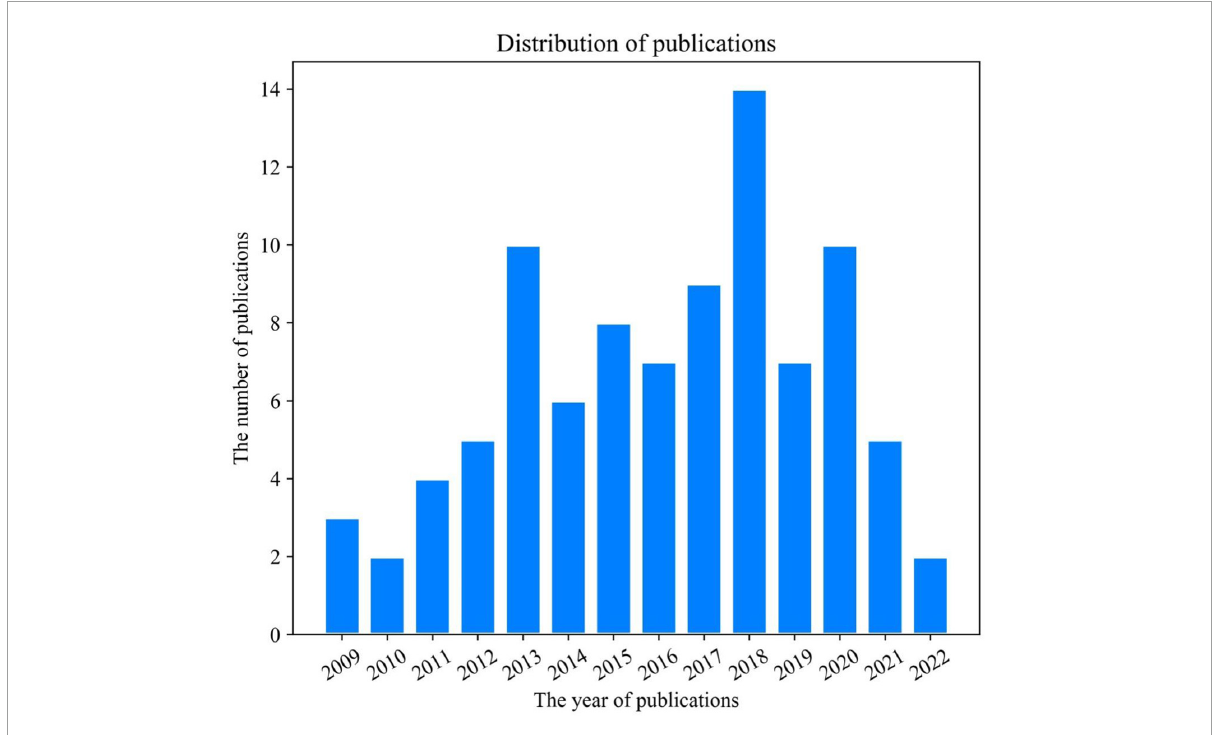
FIGURE1 Distribution of publications in